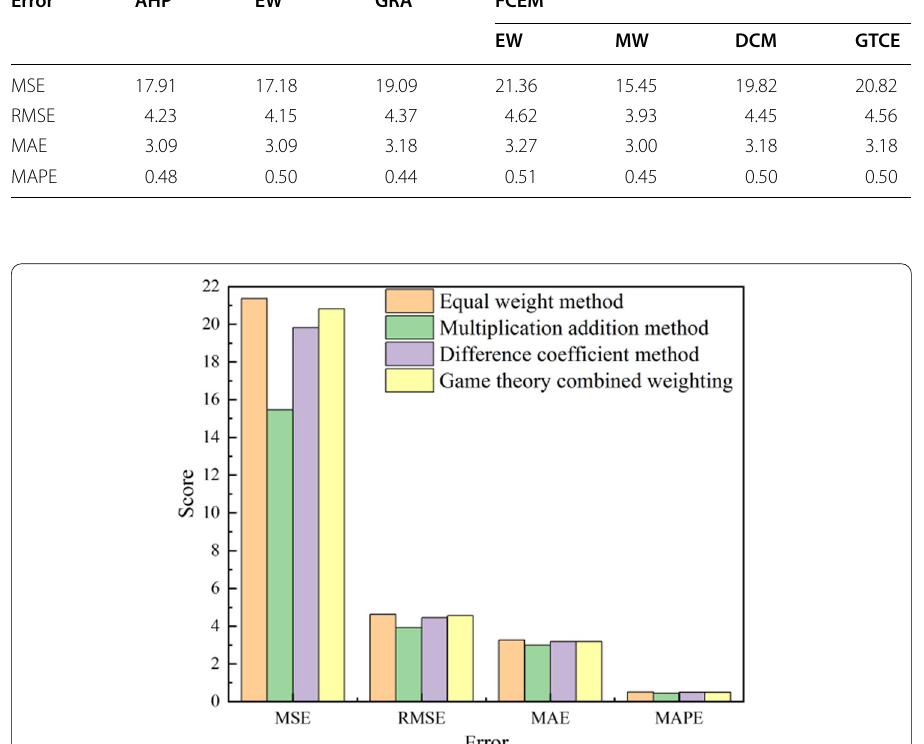
Fig. 6 Comparison of errors of different combination weighting methods